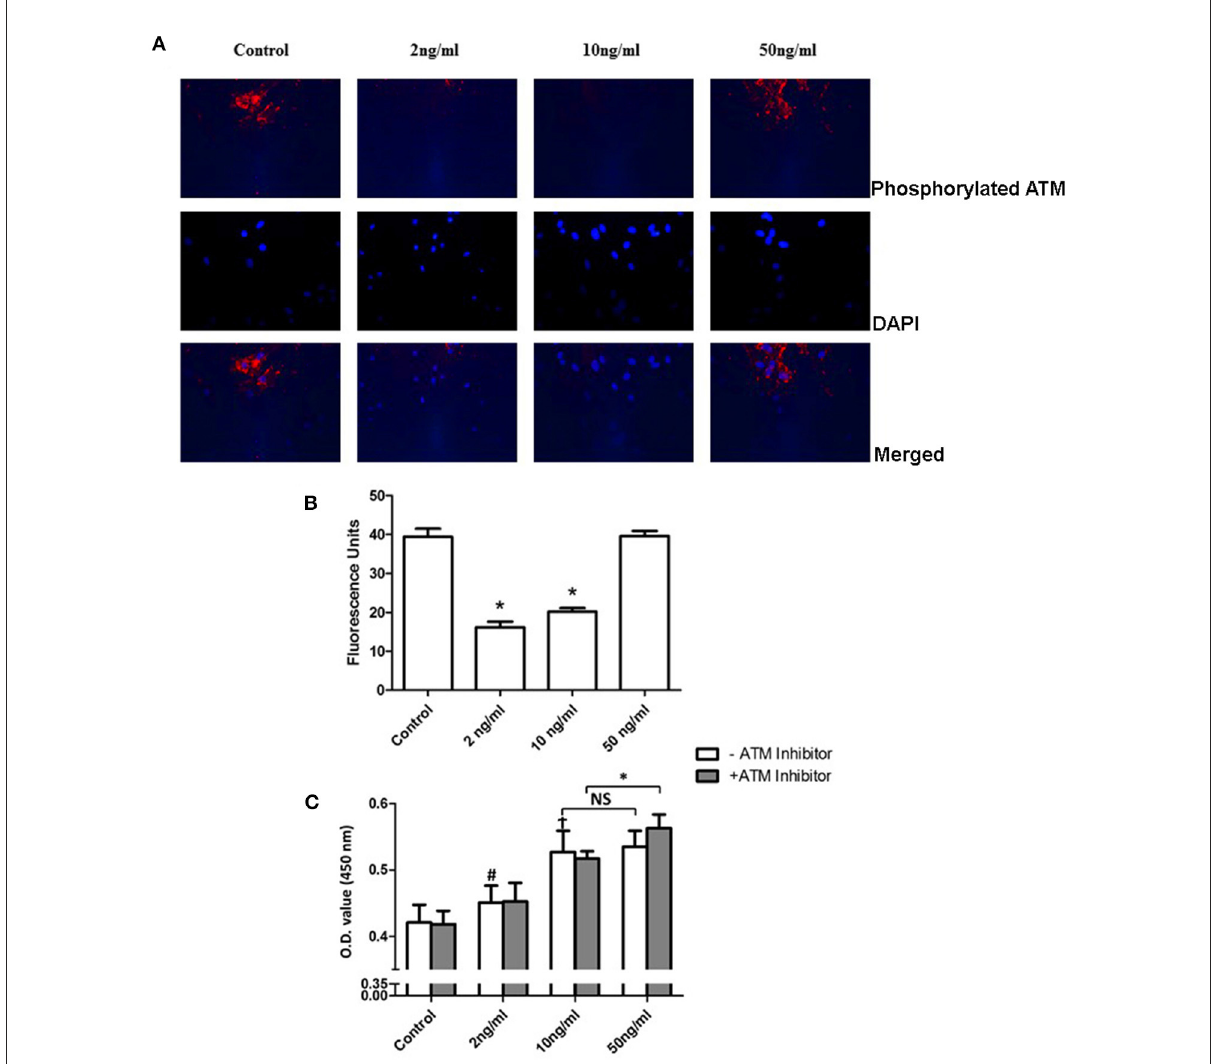
FIGURE3 Phosphorylation of ATM inhibited proliferation of PASMCs under a high concentration of PDGF-BB stimulation. (A) Phosphorylation of ATM levels of PASMCs under different concentrations. PDGF-BB was shown in the first panel. Images of DAPI staining for the nucleus were shown in the middle panel. The merged images were represented in the last panel. (B) Quantification of the phosphorylation level of PASMCs showed in the bar graph. Both the 2 and 10ng/ml of PDGF-BB groups showed a significant lower level of phosphorylation of ATM ( P < 0.05). (C) Cell Counting Kit-8 results showed that the 2, 10, and 50ng/ml groups had significantly higher proliferation levels compared to the control group ( P < 0.05). With the pretreatment of ATM inhibitor, a significant increase was found between the 10 and 50ng/ml groups ( P < 0.05). N = 5. * P < 0.05 vs. control. # p < 0.05, vs.